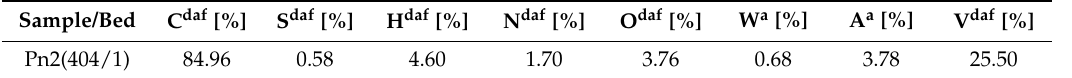
Table 1. The results of the elemental and technical analyses of the research